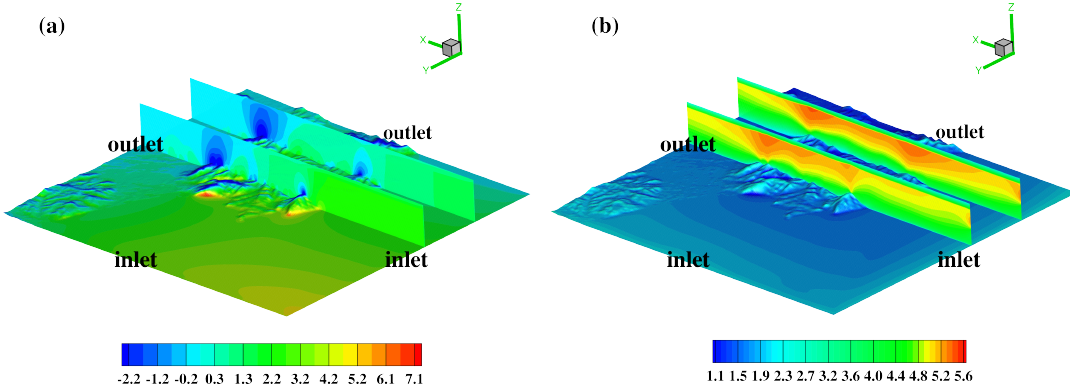
Figure 2. The distributions of the pressure ( a ) and the wind velocity ( b ) at 12:00 a.m. UTC, 1 October 2013, over the target area where the x and y represent the east and north directions, respectively. Two vertical cross sections are also included to provide 3D images. The dominant wind direction is